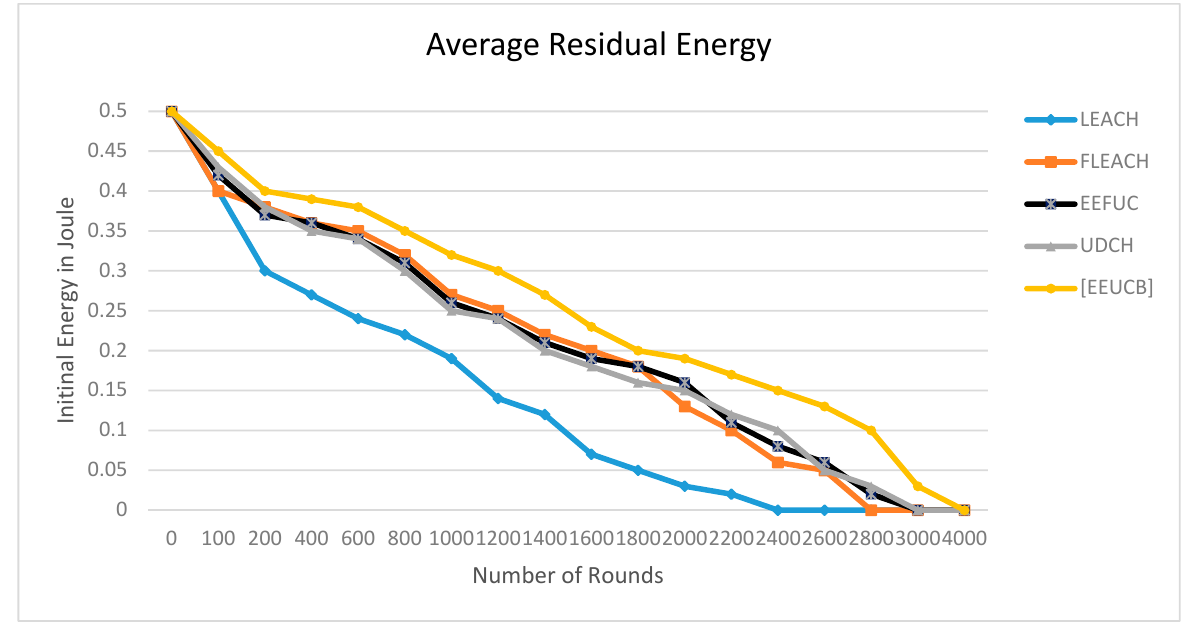
Figure 13. The average residual energy. Table 8. Standard deviation residual energy.